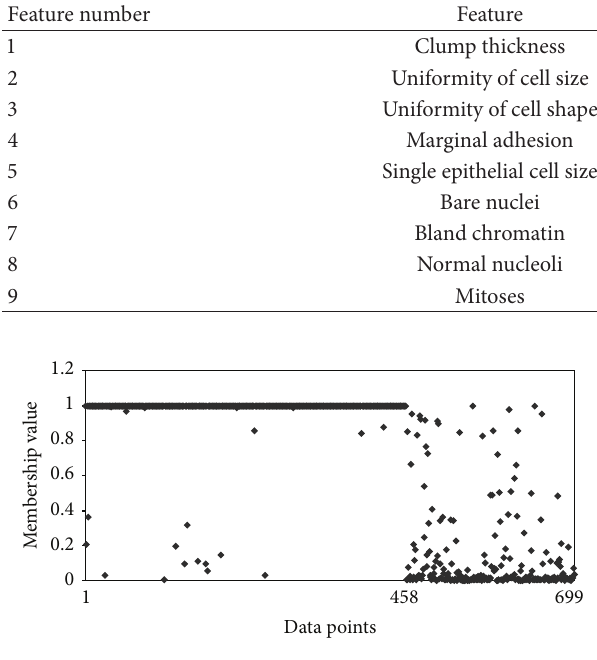
Figure1:Membershipfordifferentdatapointsforthebenigncluster byusingAhmadandDey[22]distancemeasurefor 𝑚 = 1.1 .Thefirst 458 data points are benign and next 241 data points are malignant.